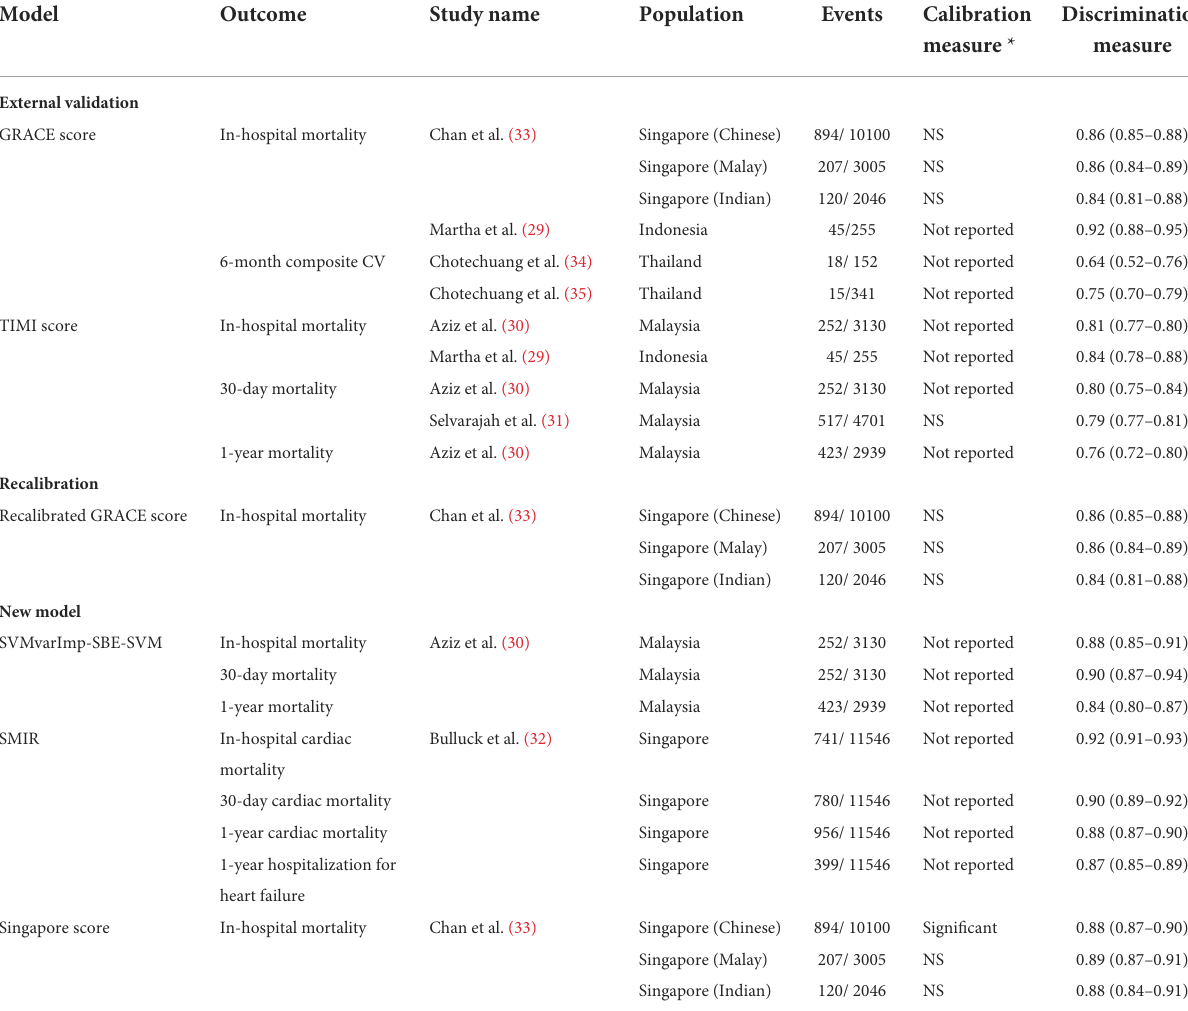
TABLE 2 Summary of predictive performances of included prognostic